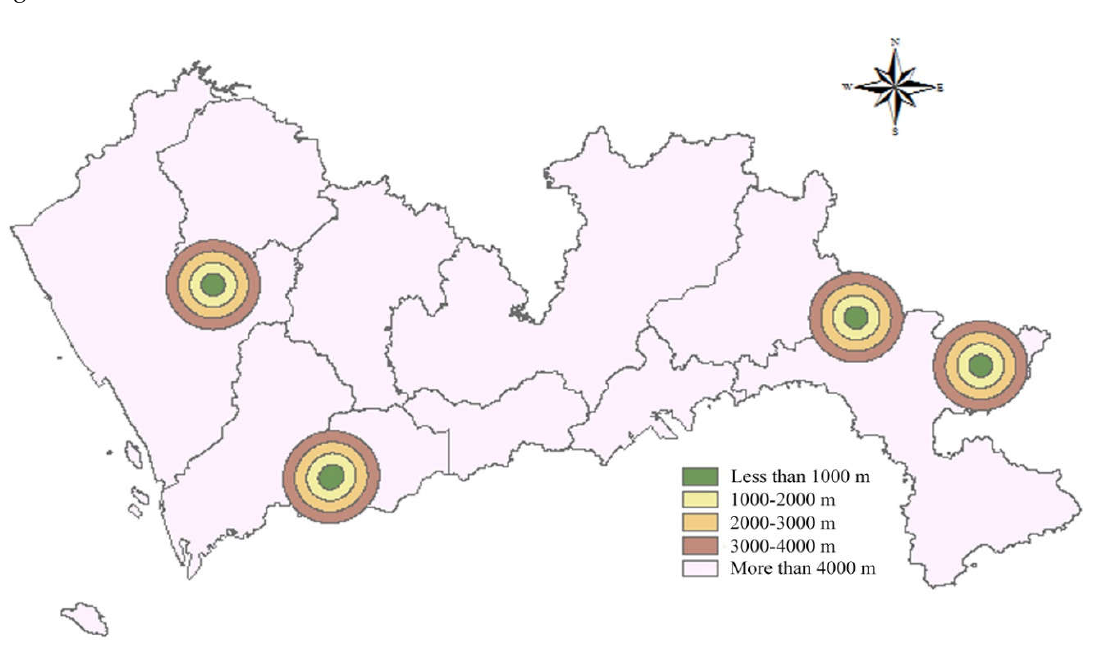
Figure 3. Map of distance to nature reserve.